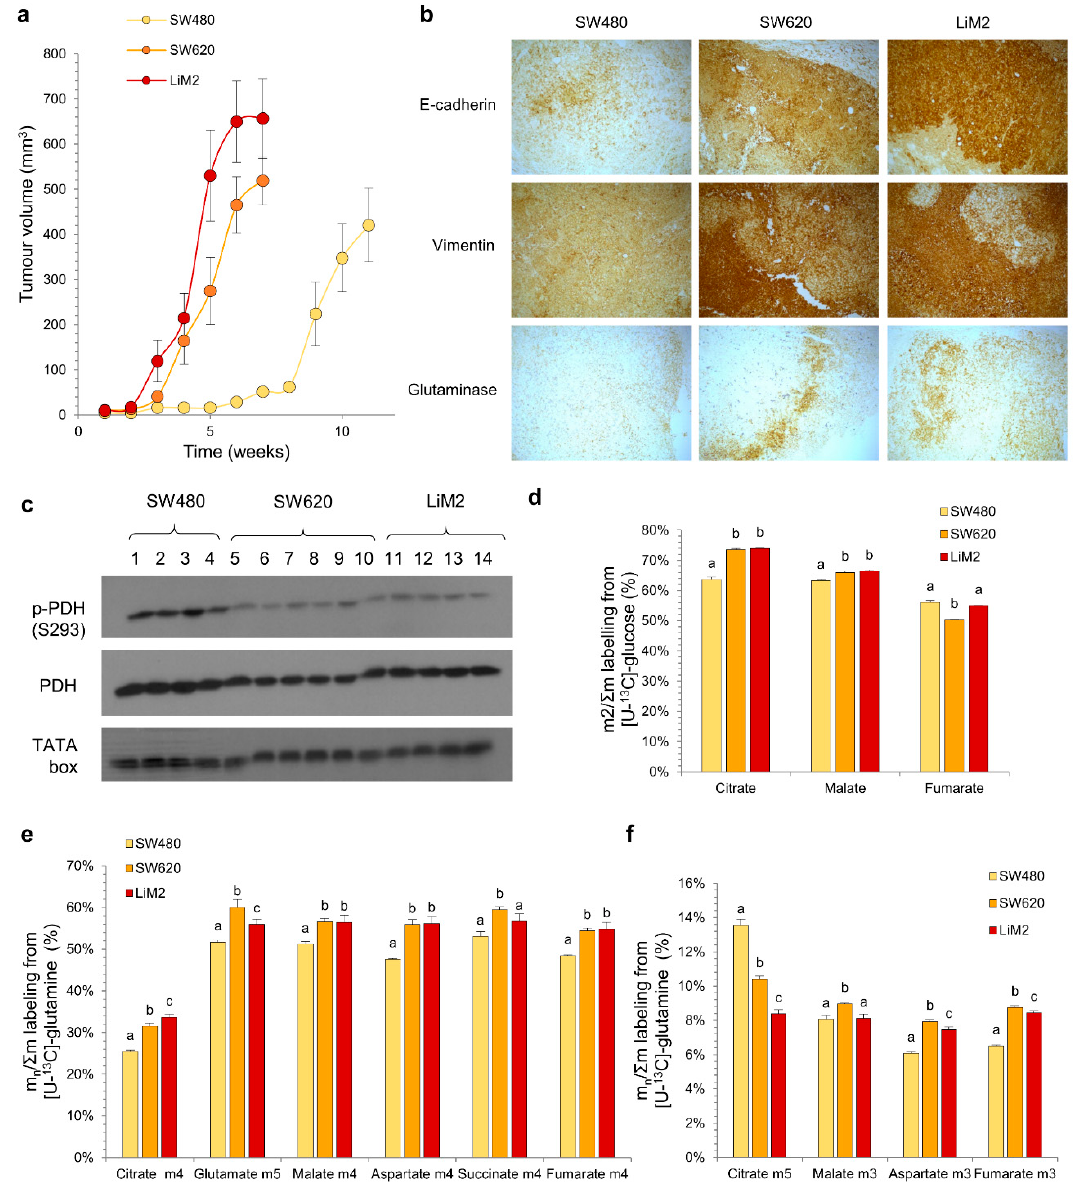
Figure 3. The metabolic adaptation of the metastatic cell lines observed in vitro is maintained in an in vivo scenario. ( a ) Tumour volume evolution measured by calliper. ( b ) Immunohistochemical staining of paraffin-embedded tumour slides (40×). ( c ) P-PDH (phosphorylated pyruvate dehydrogenase at S293) and PDH (total pyruvate dehydrogenase) protein levels tested by western blotting of tumour extracts. TATA box was used as a loading control. Samples 1–14 indicate extracts from different mice that were injected with SW480 (1–4), SW620 (5–10) or LiM2 (11–14). ( d ) Glucose contribution to TCA cycle measured from a tumour extract after a 15-min bolus of [U- 13 C]-glucose (20 mg/35 g) before the mice were culled. ( e ) and ( f ) Glutamine contribution to TCA cycle measured from a tumour extract after two boluses of [U- 13 C]-glutamine (6 mg/35 g, with 15 min interval) before the mice were culled, representing ( e ) oxidative metabolism of glutamine and ( f ) reductive carboxylation. a,b,c A one-way ANOVA and Scheffe’s test for multiple comparisons was performed for the factor “cell line”.